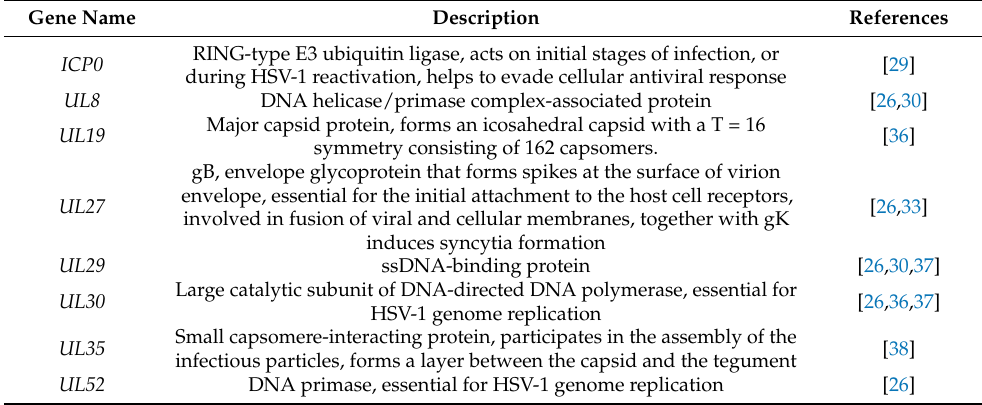
Table 1. Characteristics of HSV-1 genes used as targets for CRISPR/Cas9